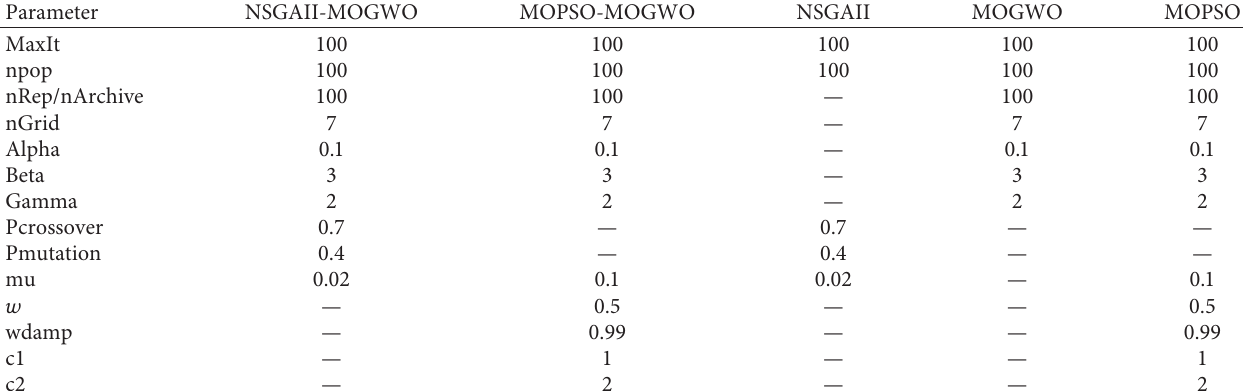
Table 11: Parameters of MOGWO-based hybrid